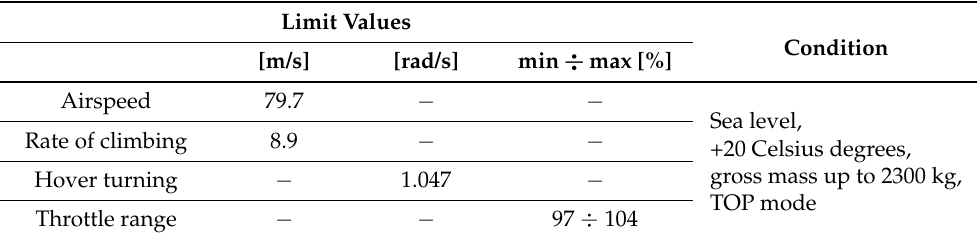
Table 4. Airspeed value ([24], page 23). Hover turning velocity and throttle range ([23], pages 43 and 35). Rate of climbing (page 60 in [26]). Limit